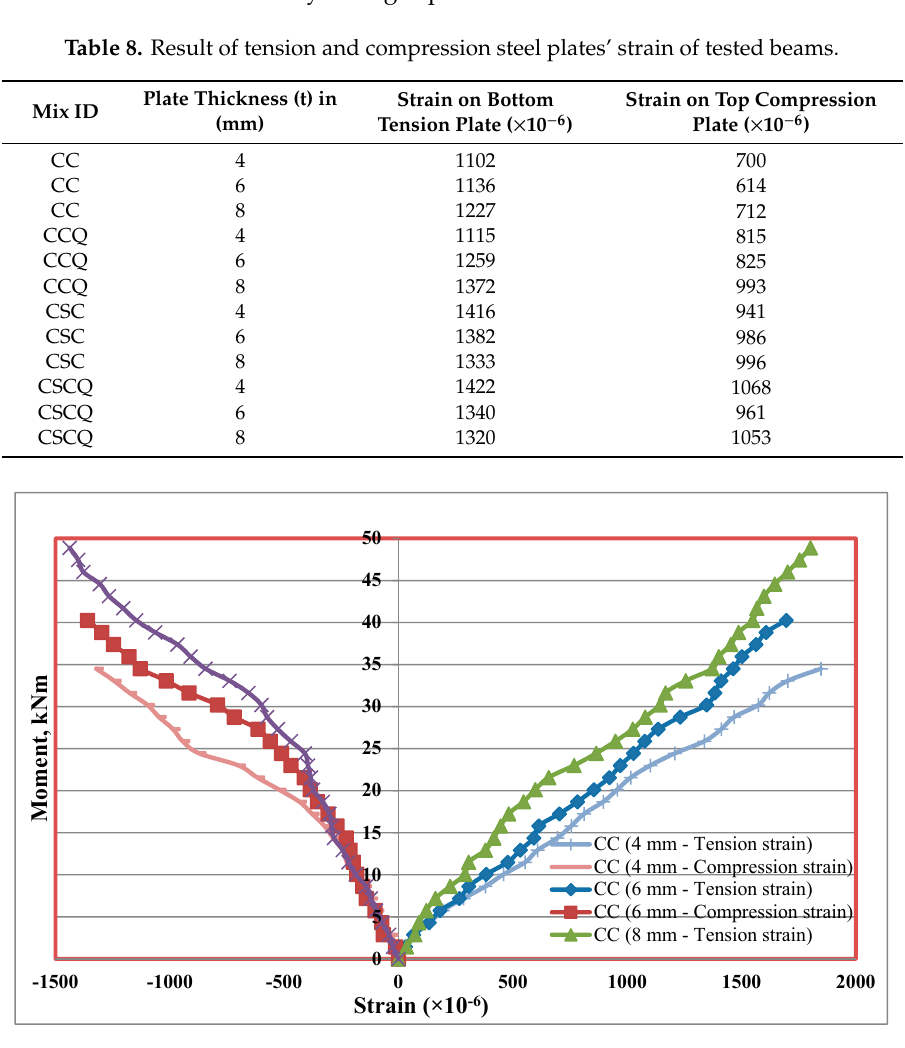
Figure 19. Strain distribution of SCS beams used with CC mix.